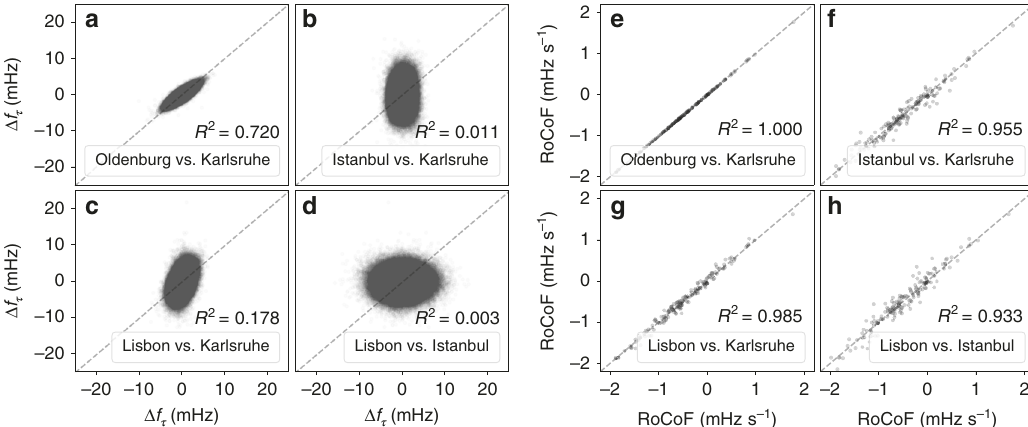
Fig. 6 From localised fl uctuations to bulk behaviour. From left to right, we move our focus from short timescales (increments) to long timescales (RoCoF). a – d Short time increments are mostly independent. We compute the increment statistics Δ f τ = f ( t + τ ) − f ( t ) for the increment time τ = 1 s at the four sites in Continental Europe. The squared correlation coef fi cient R 2 is rounded to 4 digits. See also Supplementary Note 4 for larger lags τ and more details. e – h Correlations at the long timescale. We record the estimated rate of change of frequency (RoCoF) d f /d t every 60 min for all four grid locations. In the scatter plots, each point represents the RoCoF or increment value Δ f τ computed at two different locations at the same time t . Short timescale dynamics, as determined by frequency increments τ = 1 s (see Δ f τ , are almost independent on the timescale of Fig. 6a – d). We generate scatter plots of the increment value Δ f τ ( t ) at the same time t at two different locations. If the increments are always identical, all points should lie on a straight line with slope 1.